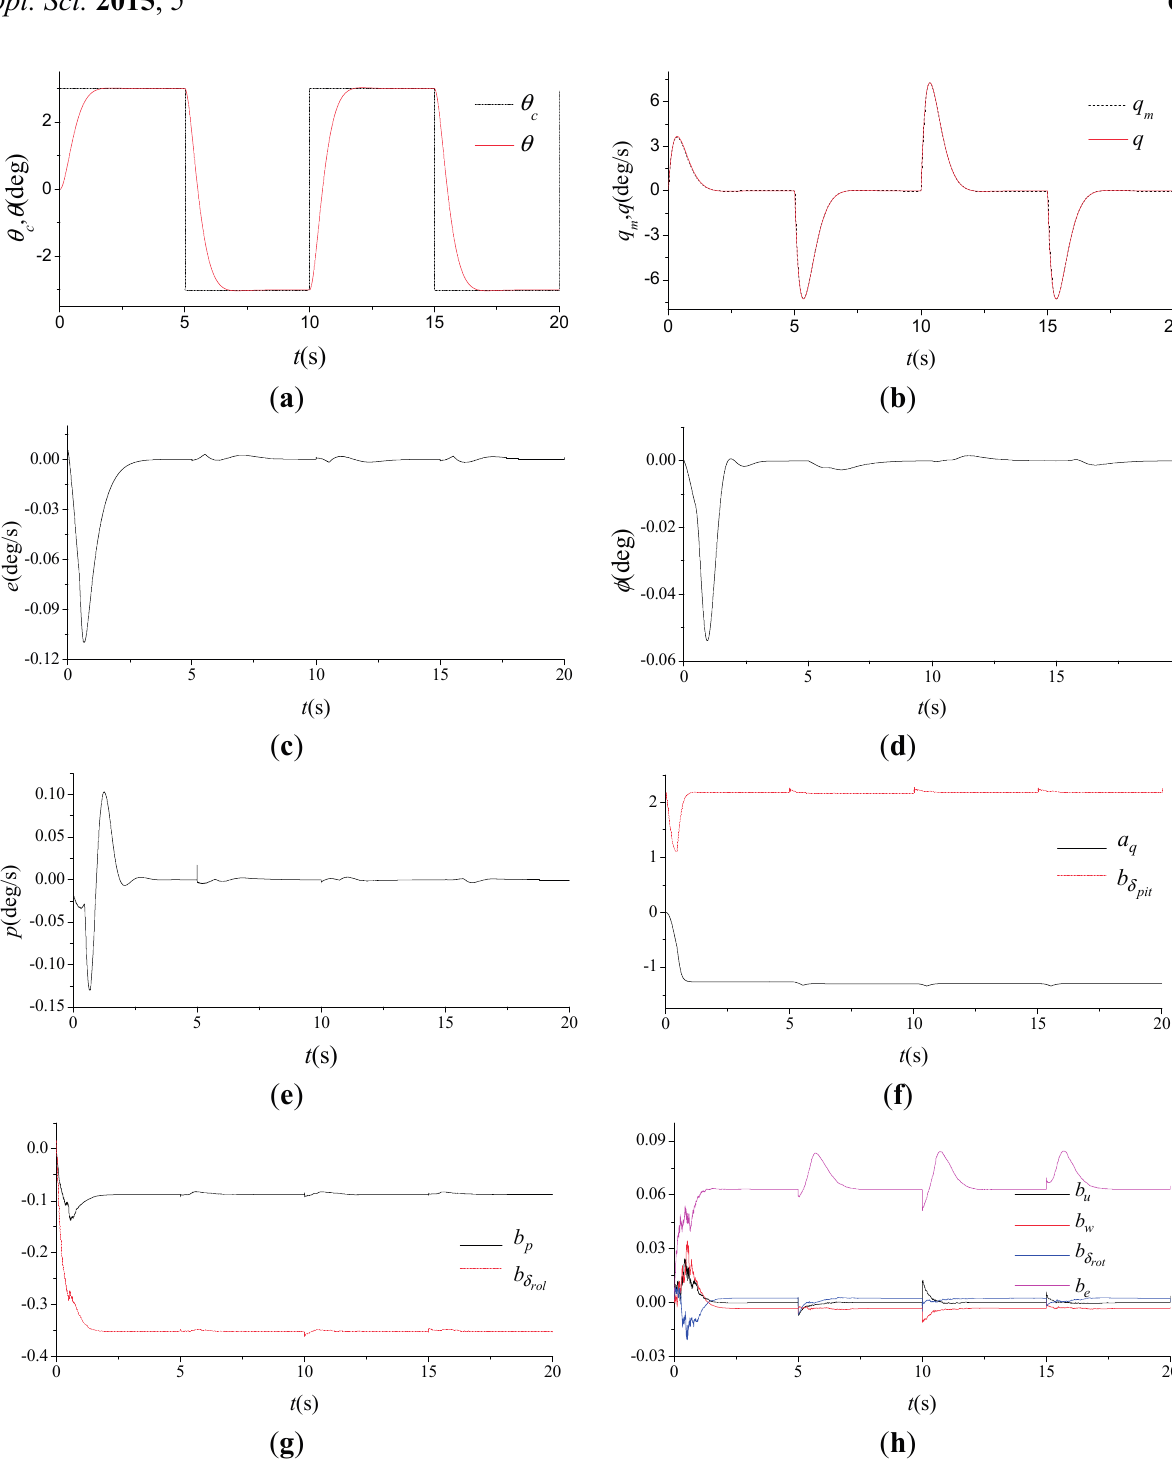
and θ ; ( b ) q and c m